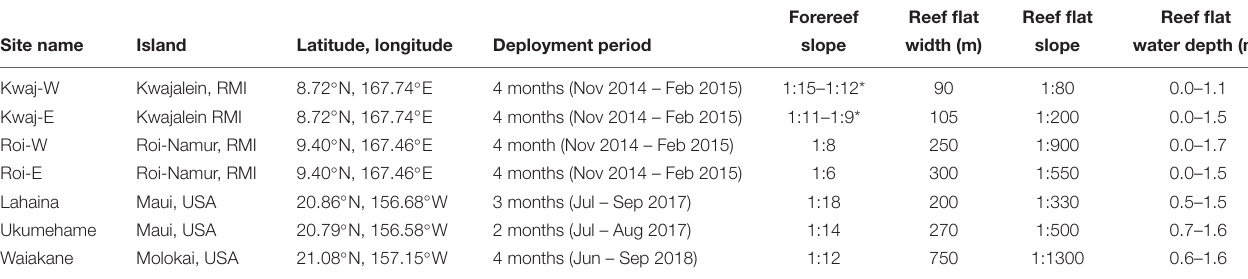
TABLE 1 | List of our 7 study sites, providing locations, latitudes and longitudes, as well as reef